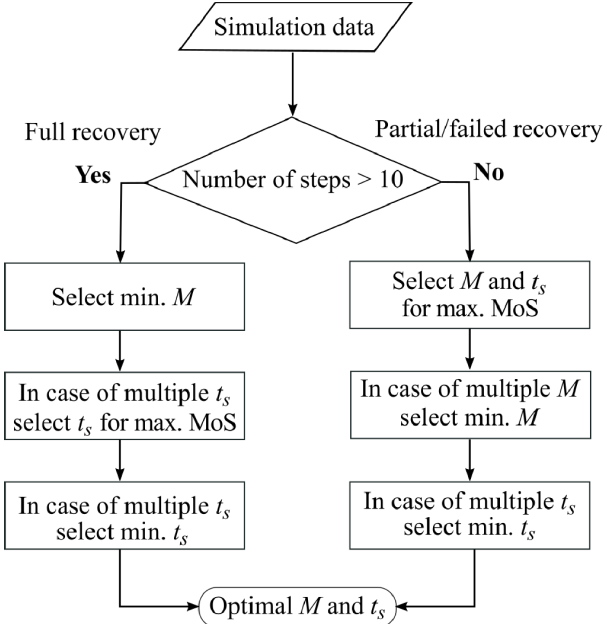
Fig 3. Workflow for selection of best-case assistance parameters. Selection procedure of assistance parameters based on the outcome measures number of steps ( n ) and margin of stability (MoS) and magnitude M and start time t s the values of the assistance